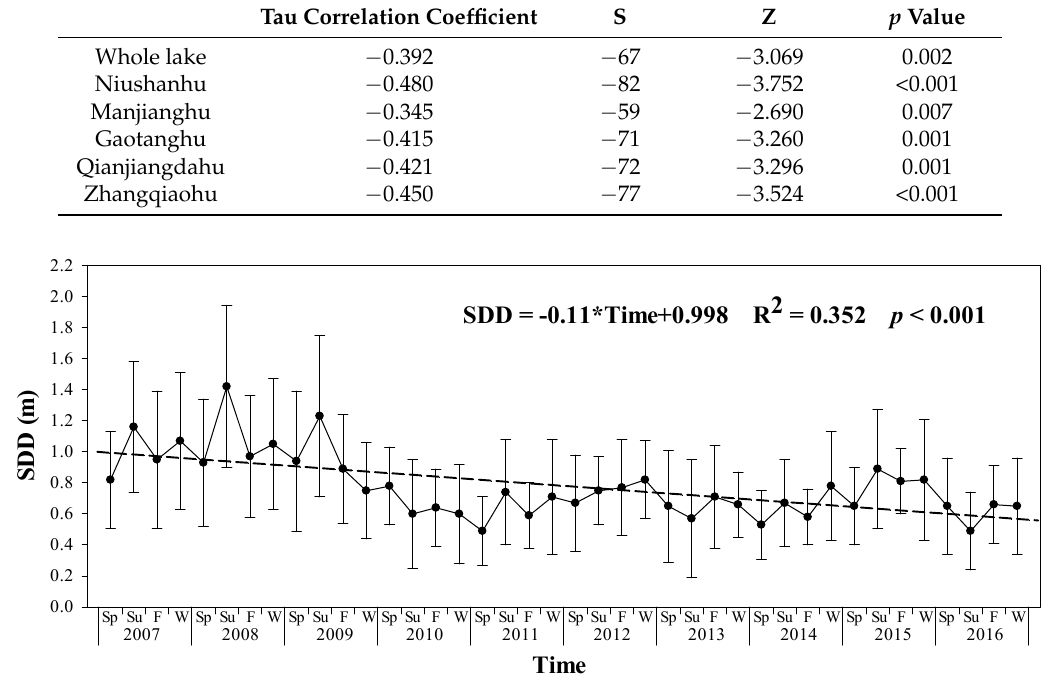
Figure 3. Long-term trend in Landsat retrieved seasonal mean SDD of Lake Liangzi during the study period. Sp: spring; Su: summer; F: fall; W: winter.